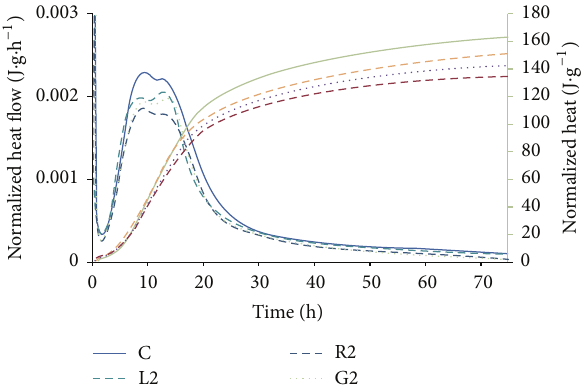
Figure 5: Hydration heat and rate of the cementitious materials.